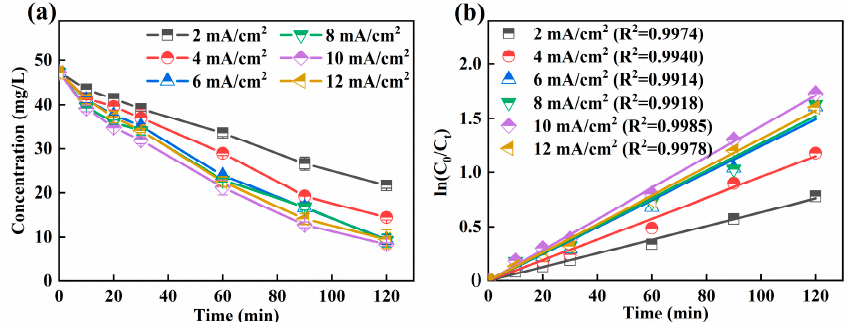
Figure 5. Decomplexation of Ni-EDTA in different current density ( a ) and kinetics fitting lines ( b ).